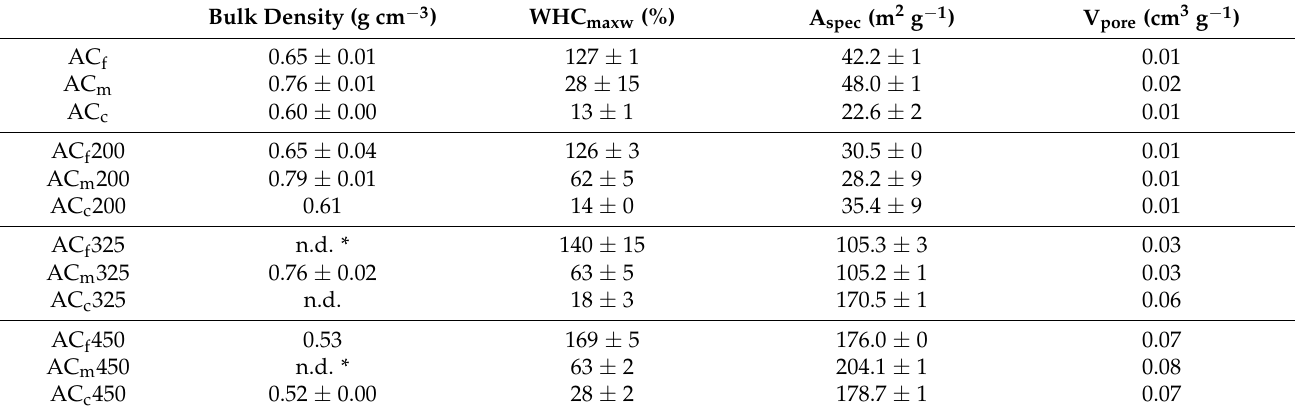
Table 5. Maximal water holding capacity, WHC maxw (% of dry sample weight), specific surface